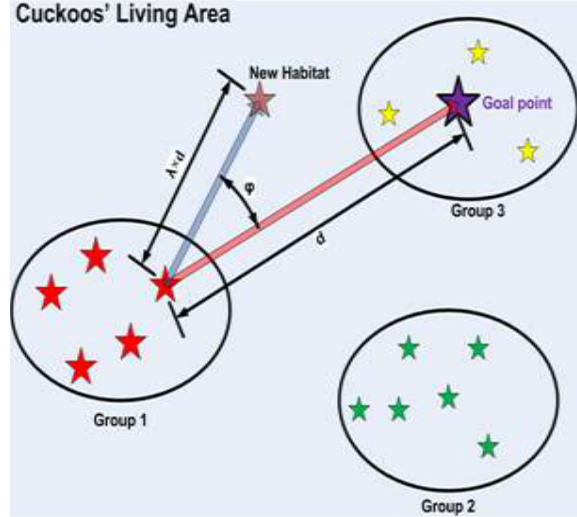
Figure 6. Immigration of a sample cuckoo toward a goal